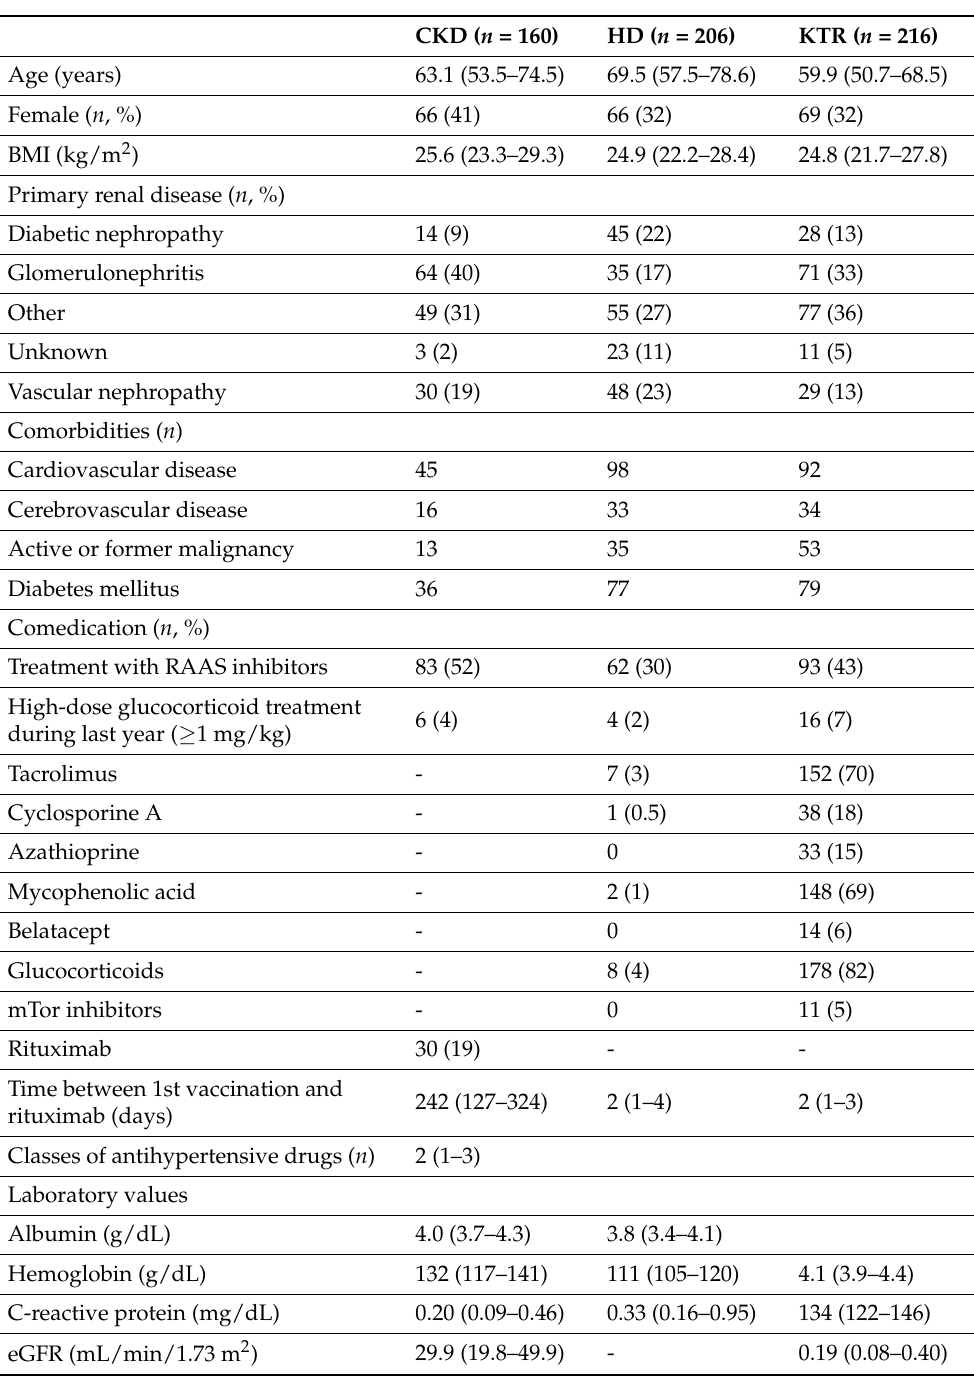
Table 1. Data is displayed as median, 25%, and 75% percentiles. Numeric data is displayed as number of participants ( n ) and percentage (%) where appropriate (sums do not add up to 100% due to